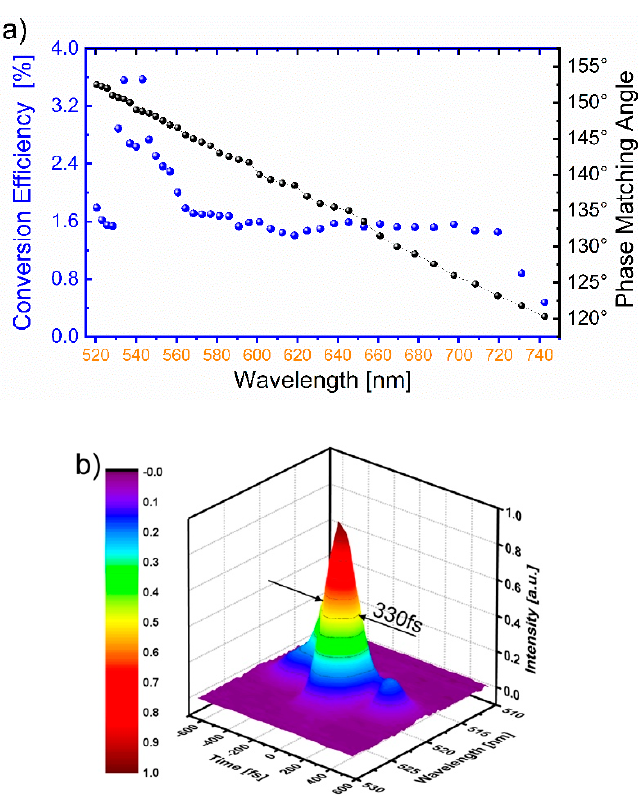
Figure 3. Tunable SFG by rotation of the BIBO crystal and by varying the optical delay line. ( a ) The internal angle under phase-matching (black circles) and conversion efficiency (blue circles) as a function of the SFG wavelength from 520.5 to 742.5 nm by changing the internal angle of the crystal between 152.5 to 120.3°. ( b ) Cross-correlation trace obtained by SFG with a reference pulse at 1040 nm and the idler at 1042 nm. A pulse duration of 330 fs is obtained.